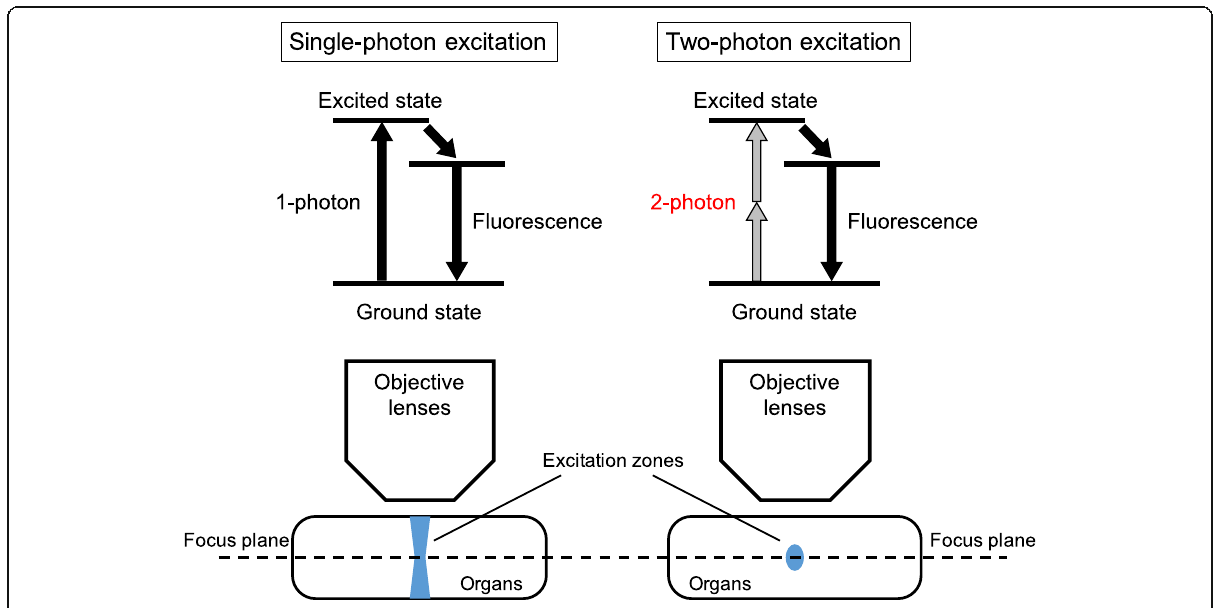
Fig. 1 The mechanism of the two-photon microscopy. Two-photon excitation is considered extremely difficult to occur, and excitation zones occur on the focus plane only. Therefore, a two-photon microscopy can bring a high spatial resolution, low phototoxicity, and low